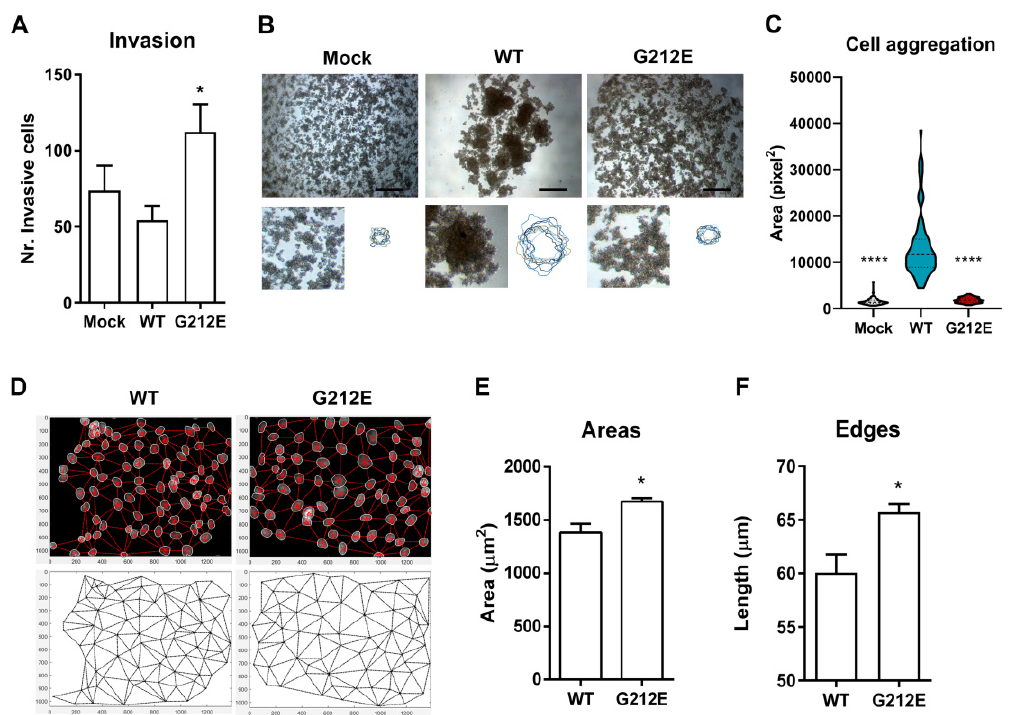
Figure 4. In vitro functional effects elicited by the E-cadherin missense variant G212E. ( A ) Invasive ability mean + SE of cells transfected with the empty vector, as well as with wild-type and G212E E-cadherin forms. ( B ) Aggregation phenotypes of the different cell lines. Scale bars represent 400 µ m. Image insights show cellular structures in detail. Scheme illustrating the outlines of 10 aggregates formed by wild-type or mutant cells. ( C ) Quantification of aggregate area. ( D ) Computational analysis of cellular distribution patterns based upon networks of neighboring nuclei. Quantitative features of networks, area ( E ) and edges length ( F ). * represents p ≤ 0.05 and **** p ≤ 0.0001.